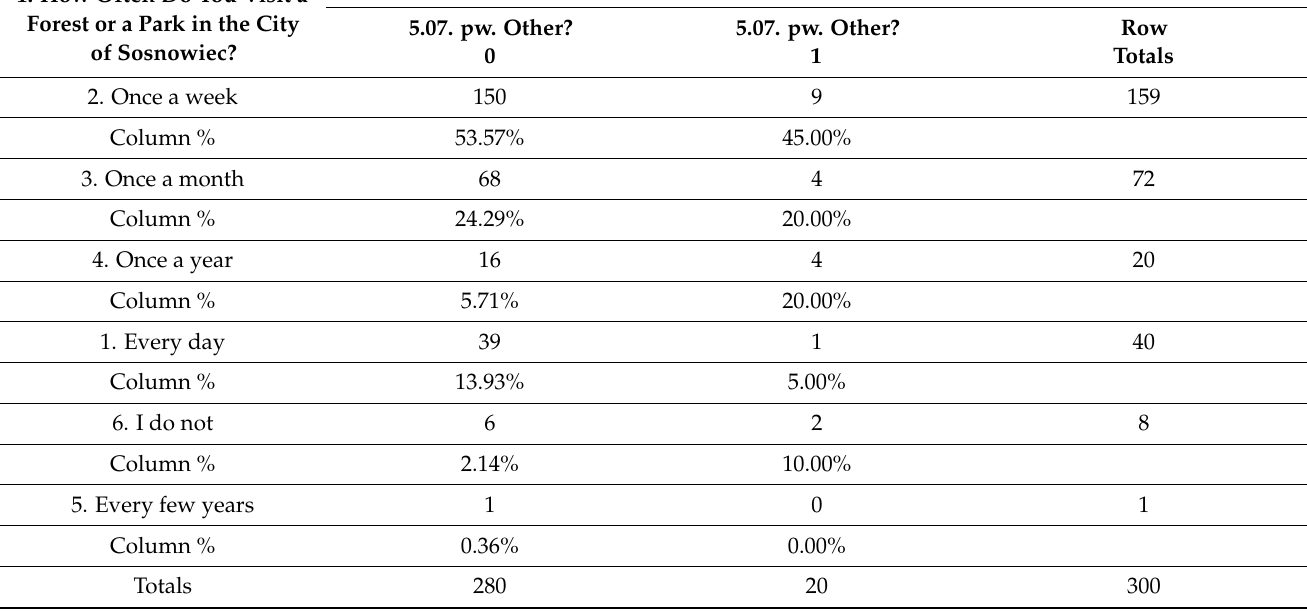
Two-Way Summary Table: Observed Frequencies (BASE) Marked Cells Have Counts >